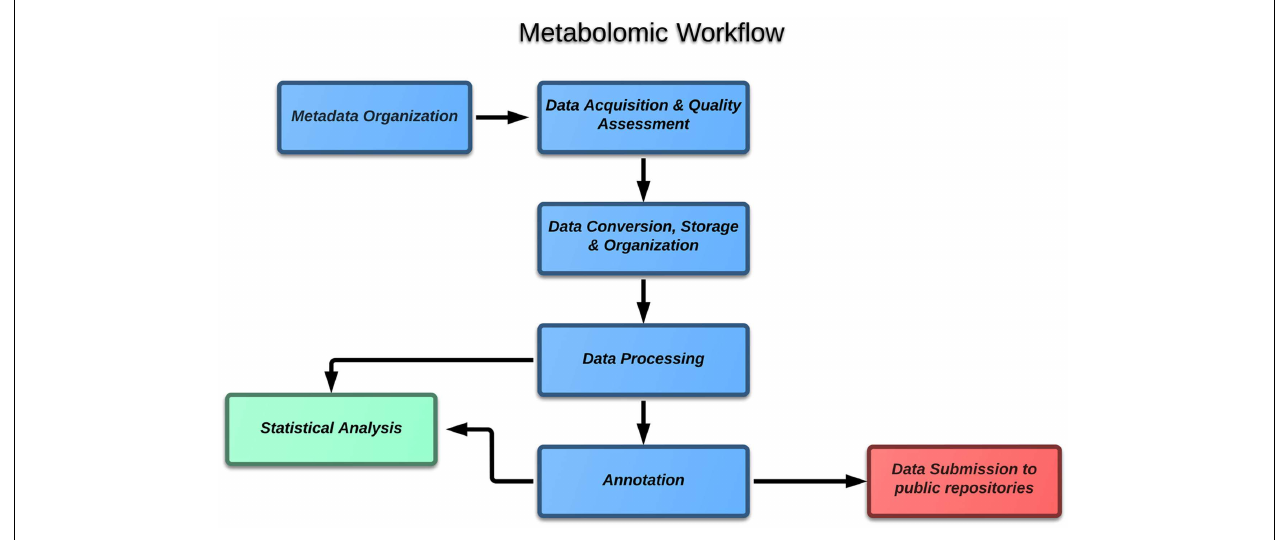
FIGURE 1 | Block diagram of the typical metabolomic experiment